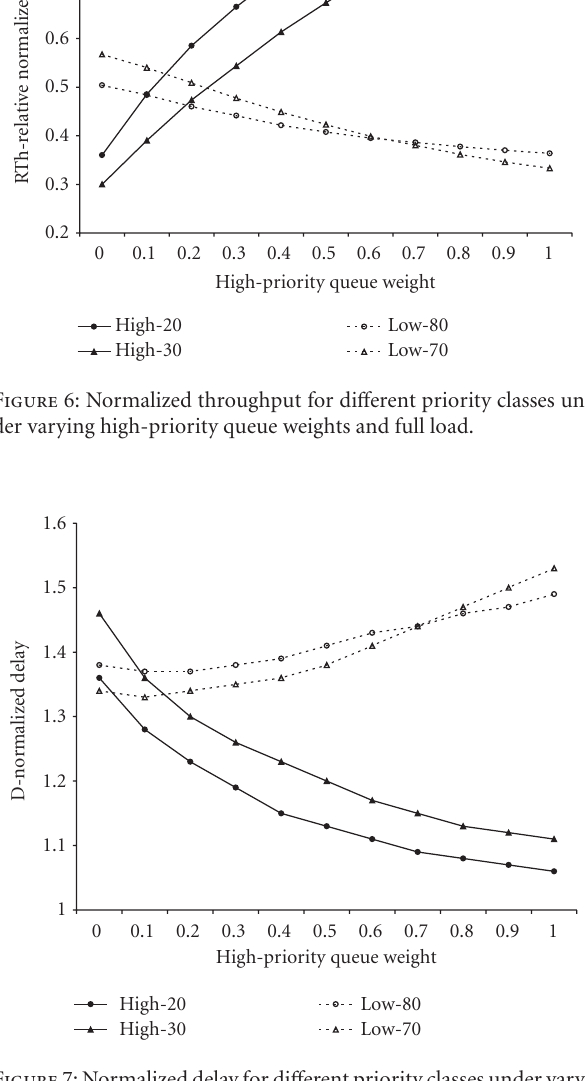
Figure 7: Normalized delay for di ff erent priority classes under vary- ing high-priority queue weights and full